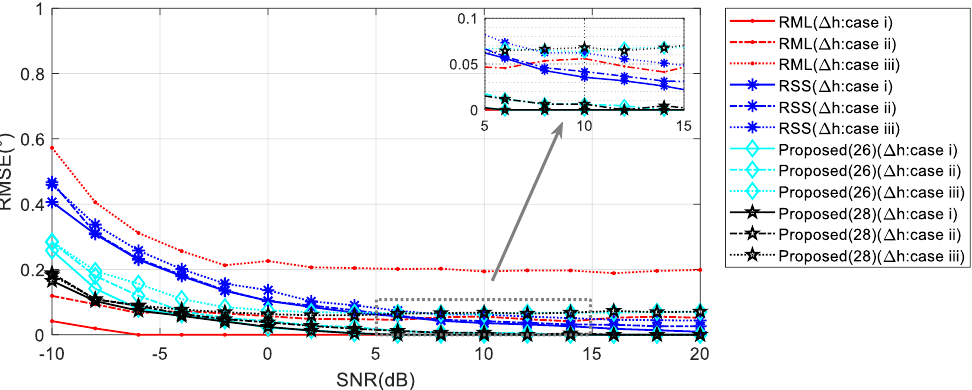
Figure 14. RMSE against input SNR with height fluctuation of reflecting surface when θ = 5 ◦ .